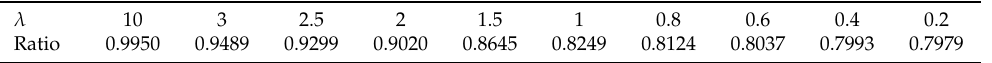
Table 1. Ratio of mean deviation to standard deviation for the TN